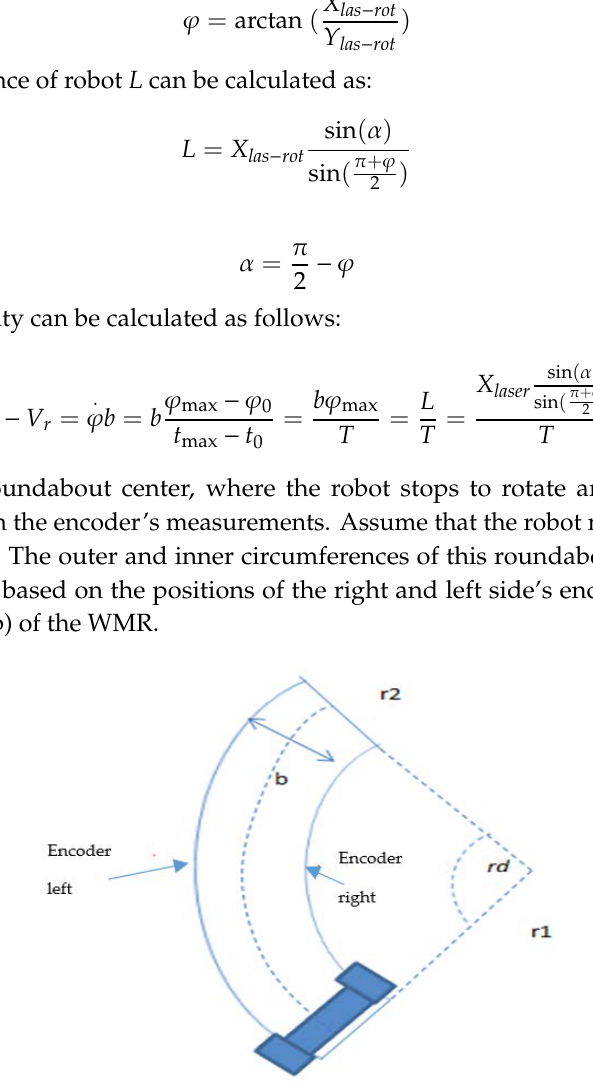
Figure 15. Robot rotation about the roundabout center to find the exit.